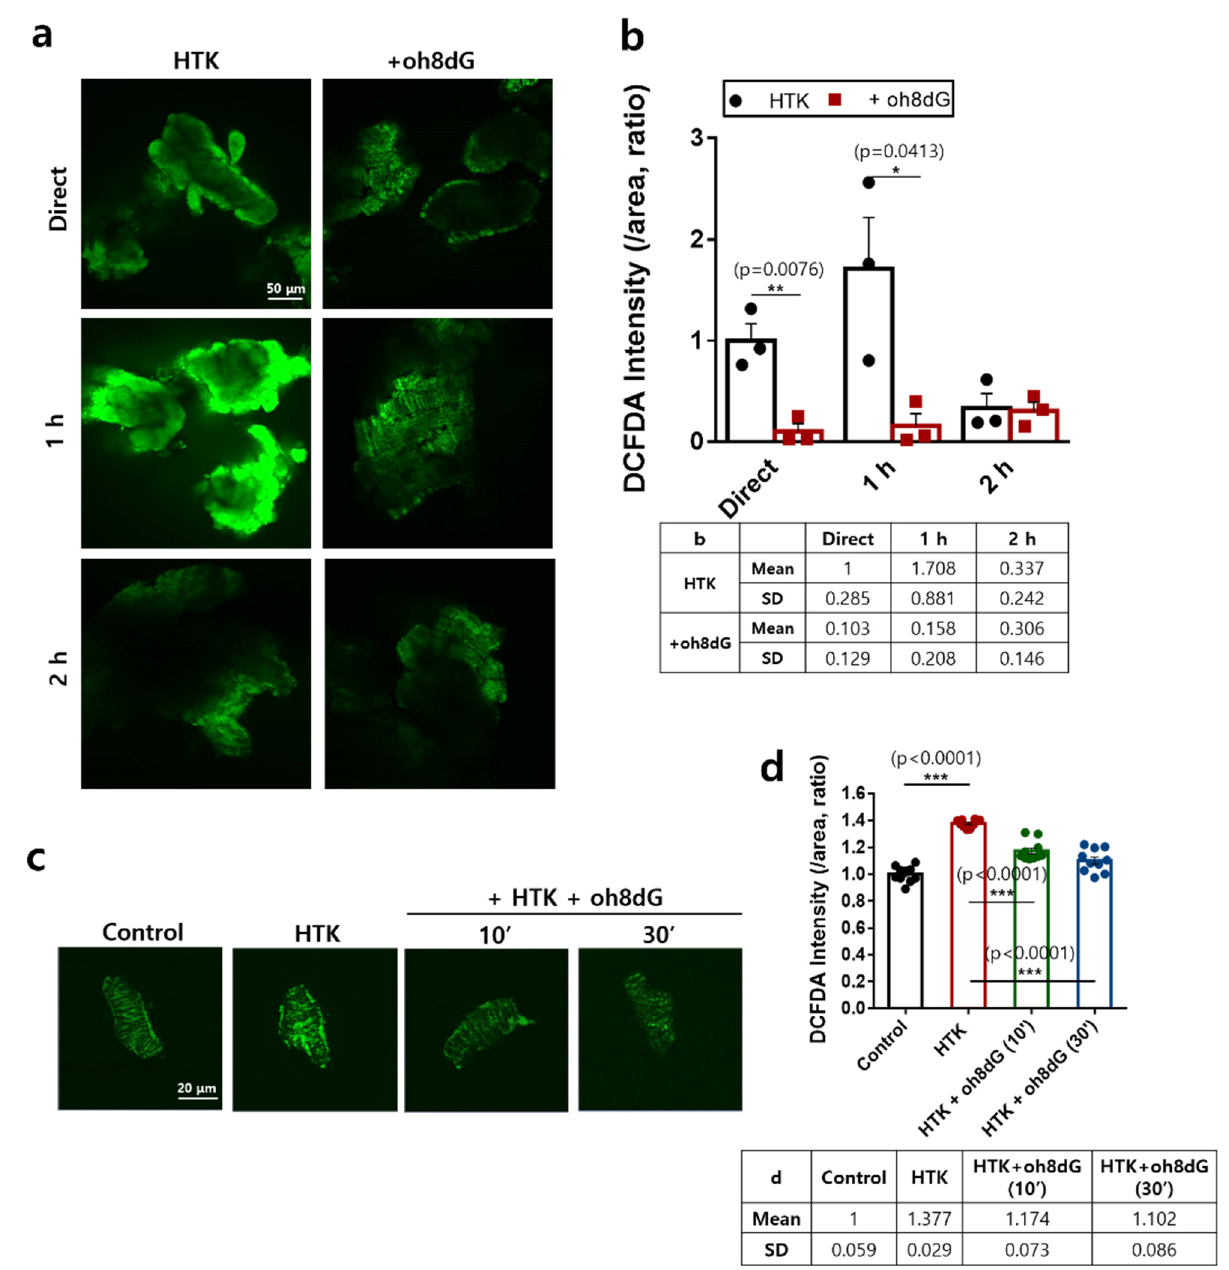
Figure 1. Treatment of oh8dG attenuated HTK-mediated ROS level in cardiac strips and isolated cardiomyocytes. ( a ) DCFDA staining in cardiac strips after cardioplegia and 100 µ g/mL oh8dG treatment for 1 and 2 h. Direct cardioplegia arrest with HTK solution using Langendorff-free cardioplegia method for 1 min. The scale bar represents 50 µ m. ( b ) Analysis of normalized intensity (total intensity/measuring area) of DCFDA. Bars present mean ± SEM ( n = 4~6 * p < 0.05, ** p < 0.01, and *** p < 0.001). The table represents mean and SD value. ( c ) DCFDA staining in isolated cardiomyocytes after cardiac arrest with cardioplegia solution (HTK) using Langendorff-free cardioplegia method for 1 min and 100 µ g/mL oh8dG was treated for 10 min and 30 min on ice. The scale bar represents 20 µ m. ( d ) Analysis of normalized intensity (total intensity/measuring area) of DCFDA. Bars present mean ± SEM ( n = 10, *** p < 0.001). The table represents mean and SD